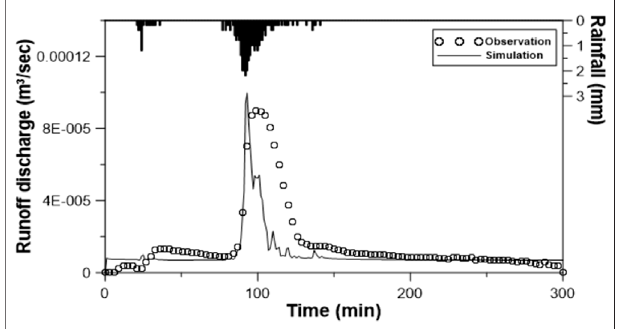
FIGURE 4 | Rainfall-runoff relationship of the simulated results from the SEEP/W model and the observed data of the green roof system at